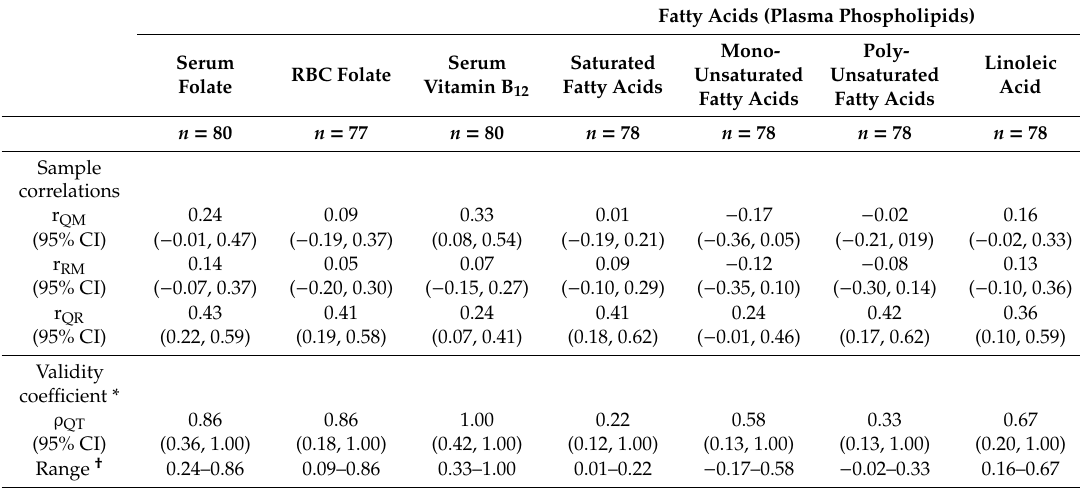
Table 3. Correlation coe ffi cients between estimates from each of the three assessment methods, and the validity coe ffi cients calculated with the method of